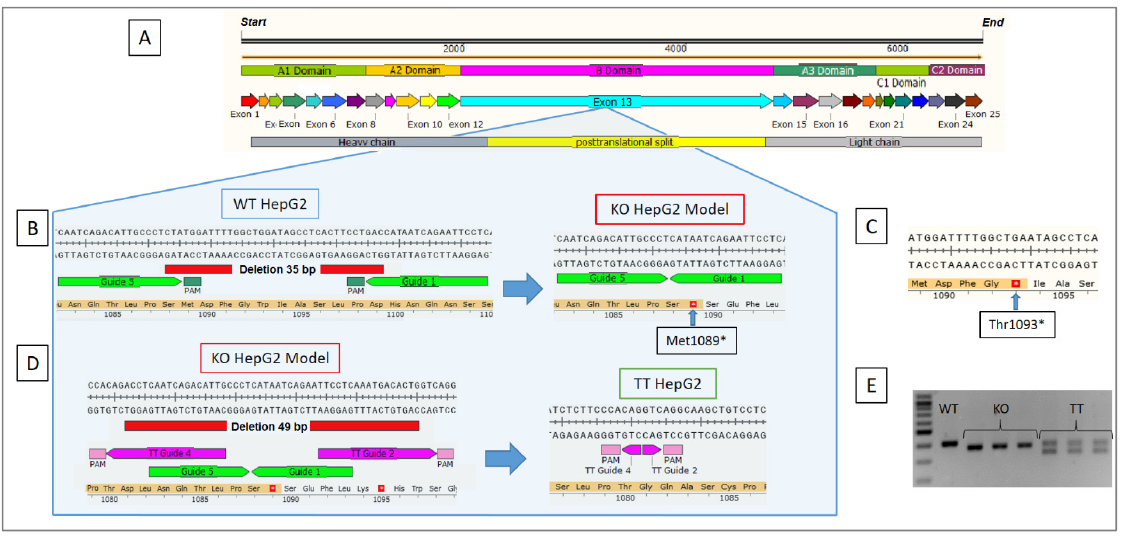
Figure 1. Gene editing strategy. ( A ) Structure of coagulation factor V. ( B ) KO HepG2 model devel- opment, simulating the similar mutation exhibited by the patient. ( C ) Patient’s Thr1093* pathologi- cal mutation. ( D ) Correction of the pathological mutation to obtain a treated HepG2 cell line (TT HepG2). ( E ) End-point PCR for the fragment of the F5 gene on the wildtype HepG2 cell line, the three KO HepG2 clones (LO1, LO8 and LO9) and TT HepG2 (LO1, LO8 and LO9). A 100 bp FastGene molecular marker from Nippon genetics (Japan) was used. Cells that contained this precise sequence were selected through colony-forming units (CFUs), and the DNA of these clones was analyzed by Sanger sequencing. Some clones were shown to exhibit the sought-after mutation (Figure 2B). For the next assays, three c.3263–3298del, p.Met1089* mutation-positive clone cell lines were used, called LO1, LO8 and LO9.